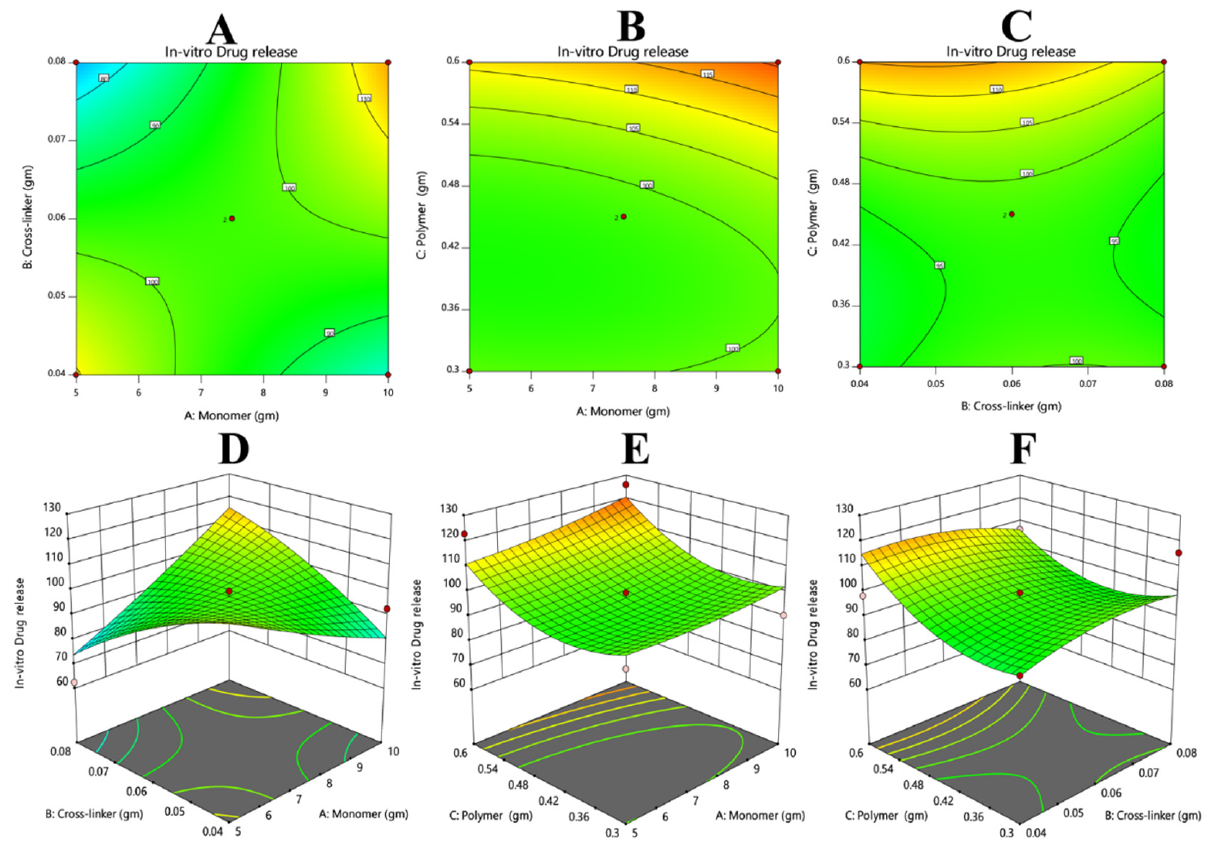
Figure 8. ( A , D ) Shows the crosslinker has a more pronounce effect on decreasing the release of the drug as compared to the monomer; ( B , E ) shows that the monomer was more effective at control- ling the drug release as compared to the polymer. ( C , F ) The crosslinker was more efficient at re- ducing the release of the drug as compared to the polymer. Table 4. Comparison of the predicted outcomes and obtained results of β -CD